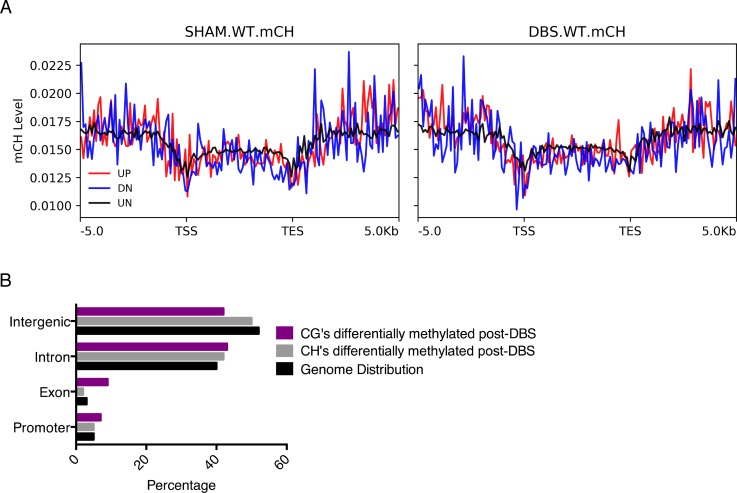
mCH levels do not show distinct signatures on DBS up- or downregulated genes.(A) Quantification of mCH levels on promoters and gene bodies of genes that are upregulated by DBS (shown in red; FDR < 0.05, fold-change >2), downregulated by DBS (shown in blue; FDR < 0.05, greater than two decrease), or genes that are unchanged by DBS (shown in black). (B) Genomic locations of differentially methylated regions (DMRs) with a greater than 50% change in methylation following DBS. Locations evaluated: intergenic, introns, exons, and promoters, and the percentage of the genome that each location comprises is shown in black.